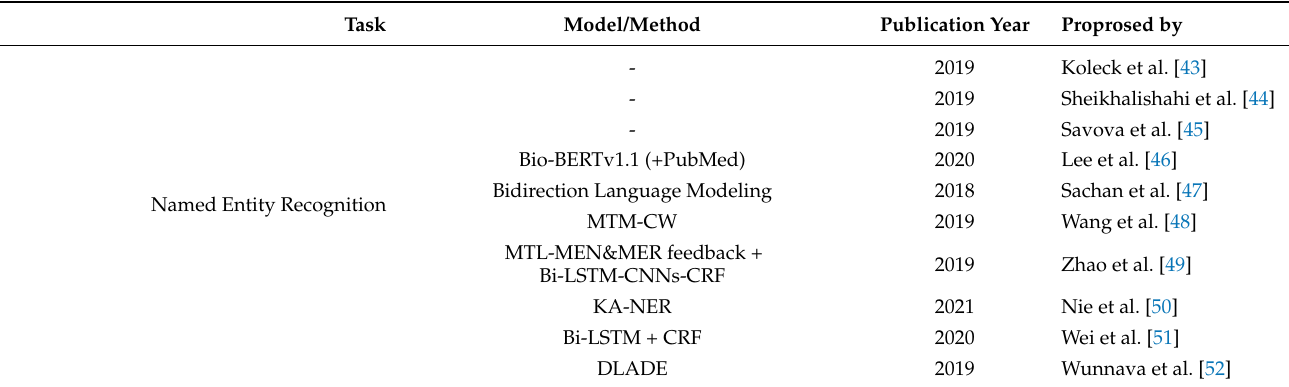
Table 2. Research Questionnaire on deep learning in the Field of